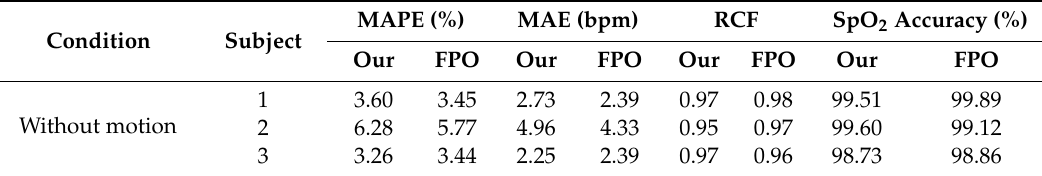
Table 6. Performance comparison between our proposed device and the Fingertip Pulse Oximeter (FPO)